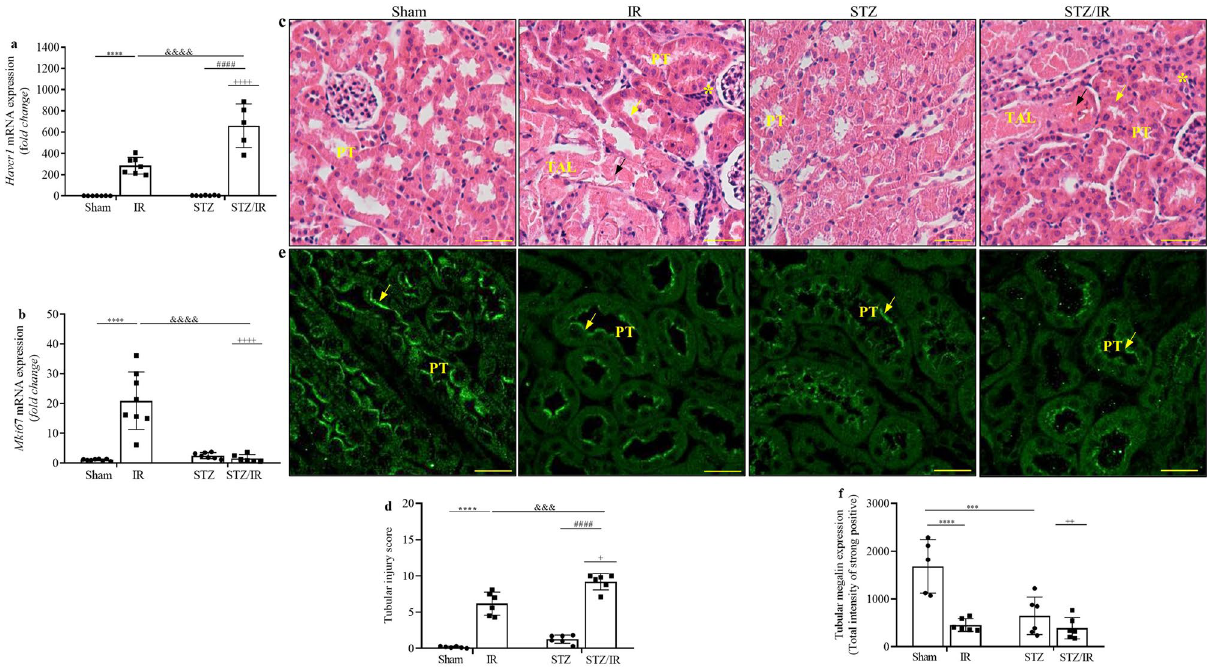
Figure 3. Effect of renal ischemia/reperfusion in vehicle- and STZ-treated mice on Havcr1 (Kim-1) ( a ) and Mki67 (Ki67) mRNA expression ( b ), as well as tubular morphology changes and megalin staining ( c – f ). + p < 0.05, ++ p < 0.01, ++++ p < 0.0001 relative to the interaction between diabetes and renal IR (STZ/IR), as indicated by two-way ANOVA (Supplementary Table S2). The Bonferroni post hoc test was also performed: ***p < 0.001, ****p < 0.0001 vs sham group; #### p < 0.0001 vs STZ group; &&& p < 0.001, &&&& p < 0.0001 vs IR group. The black arrows indicate the formation of intratubular casts; the yellow arrows indicate loss of brush border and tubular epithelial cells; and the asterisks indicate interstitial infiltration. The values are the mean ± SD (n = 5–8). For morphological studies, fixed 4-µm-thick kidney slices were stained with hematoxylin–eosin, and the images were captured and analyzed using NIS-Elements (Nikon) software coupled to a light microscope equipped with a ×40 objective (Eclipse 80i, Nikon, Tokyo, Japan). Immunofluorescence images were captured using a Zeiss LSM 510 confocal microscope equipped with a ×40 objective and laser excitation at 488 or 543 nm. The fluorescence intensity was analyzed using Aperio ImageScope software version 12.3.2. Bars, 100 μm. Sham sham-operated, IR ischemia/reperfusion, STZ streptozotocin, STZ/IR streptozotocin/ischemia/reperfusion, PT proximal tubule, TAL thick ascending